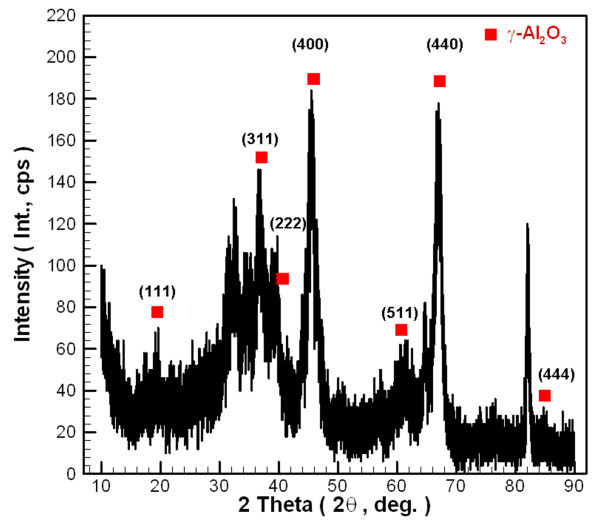
XRD patterns of Al2O3 nanoparticles.